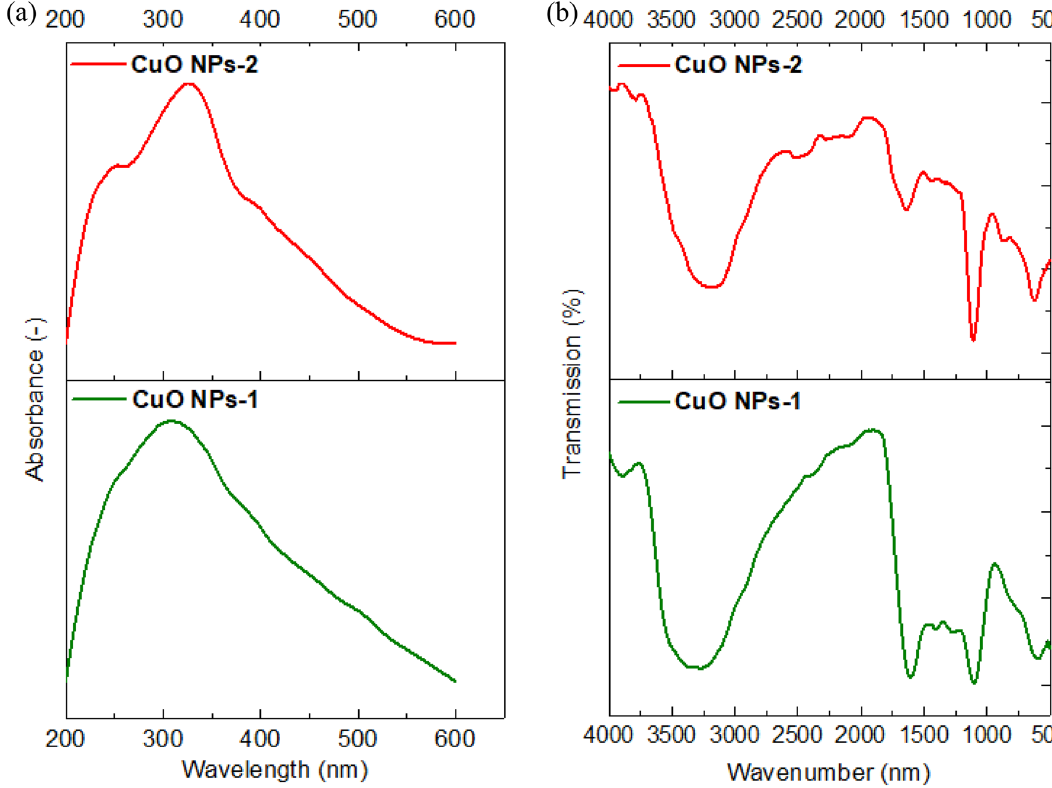
Figure 3. ( a ) UV–Vis spectra and ( b ) FT-IR Spectra of CuO NPs using mint extract (CuO NPs-1) and orange peel extract (CuO NPs-2).